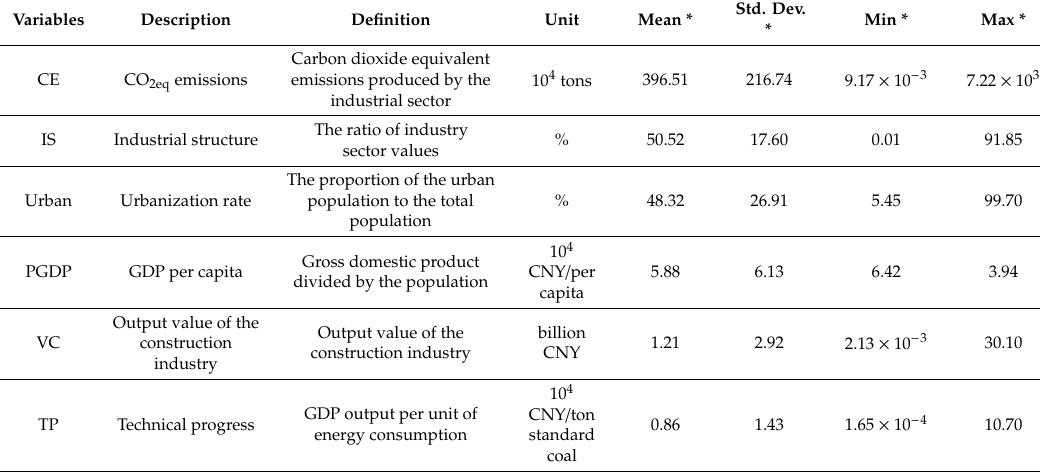
Figure 1. The study area. Table 1. Statistics of carbon dioxide equivalent (CO 2eq ) and contributing factors in Inner Mongolian counties.